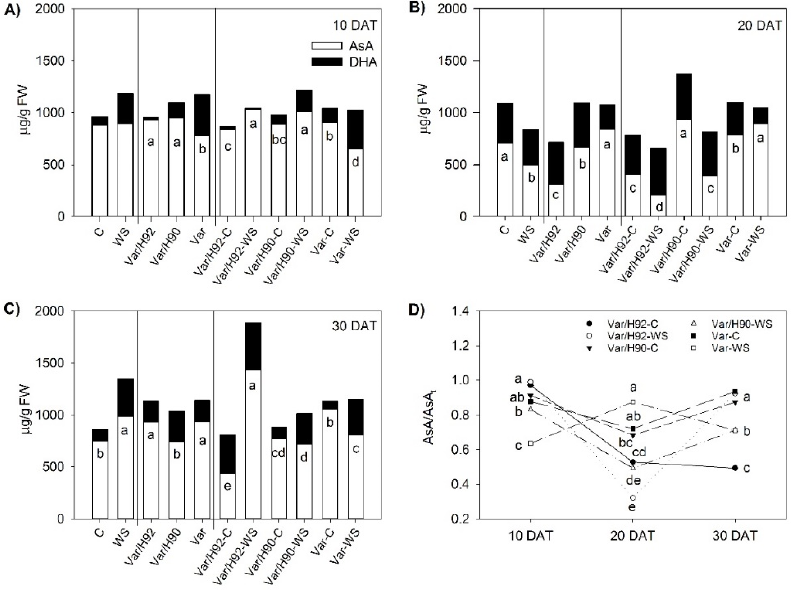
Figure 3. ( A – C ) Concentration of the different forms of ascorbate (AsA and DHA) in the leaves of the ungrafted plants (Var, variety “Sueca”) and Var grafted onto H92 or H90 (Var/H92 and Var/H90) under the water stress (WS) or control conditions (C) at 10, 20, and 30 DAT (days after treatment), respectively. Different letters indicate significant differences at p < 0.05 (LSD test) for the AsA parameter. No letters in 3A indicate no significant differences. ( D ) The AsA/AsAt ratio for the aforementioned combinations and time measurements. Different letters indicate significant differences at p < 0.05 (LSD test) for each measurement time separately. Data are the mean value for n = 4 for each plant type and treatment combination.